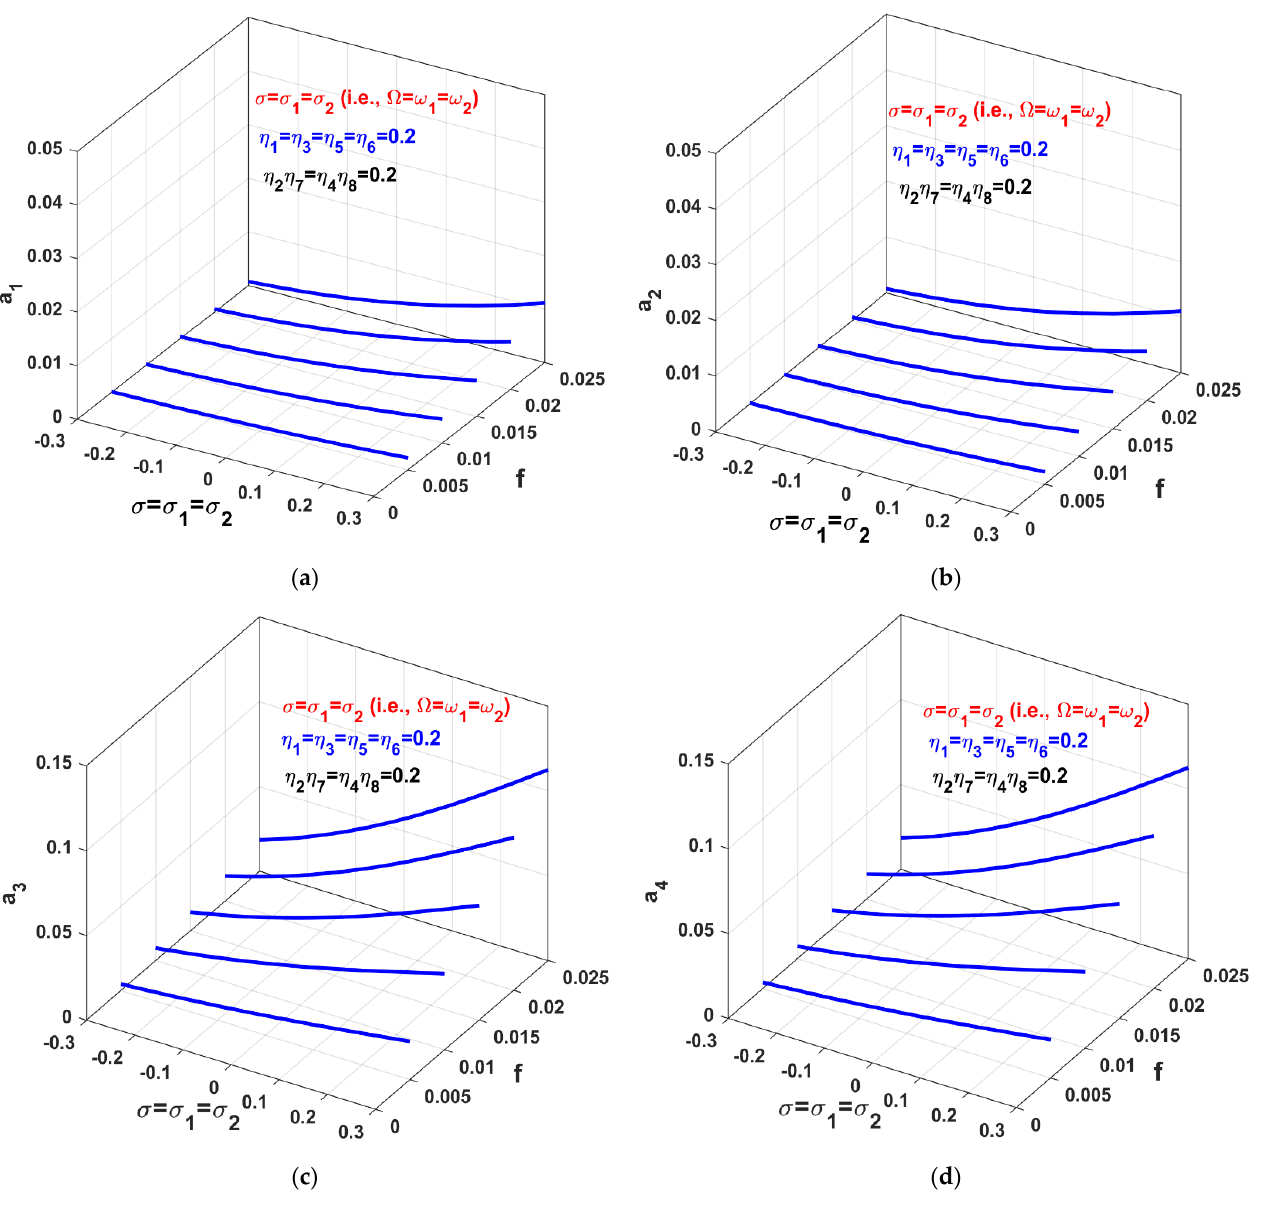
Figure 7. Vibration amplitudes of the rotor system and ALIPPF-controller using 𝜎 = 𝜎 1 = 𝜎 2 as a bifurcation parameter when 𝑓 = 0.005,0.01,0.015,0.02, and 0.025 : ( a ) vibration amplitude in 𝑋 1 direction, ( b ) vibration amplitude in 𝑋 2 direction, and ( c , d ) vibration amplitudes of the LIPPF-controller.